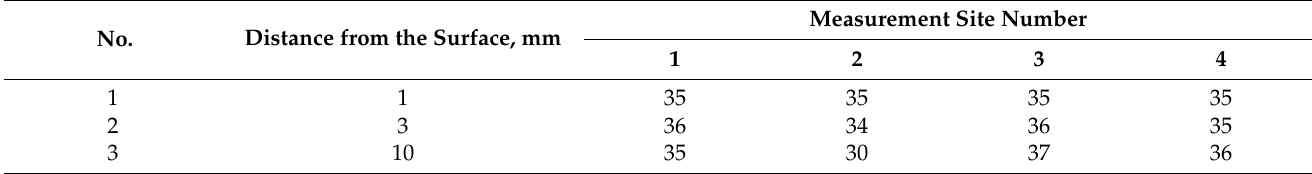
Table 4. Chemical composition of the material (steel) of the conical pick for roadheaders (Figure 11a). Chemical Element, wt.% 0.336 ↓